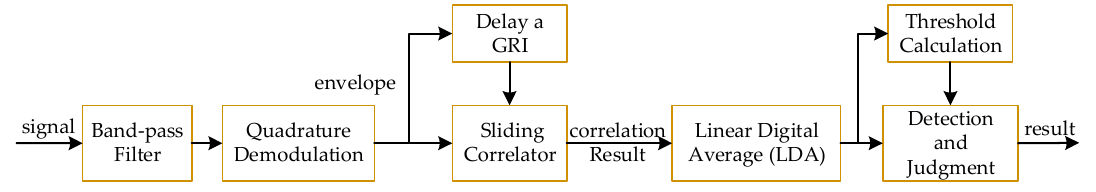
Figure 5. Flow diagram of the signal acquisition method used in this article.